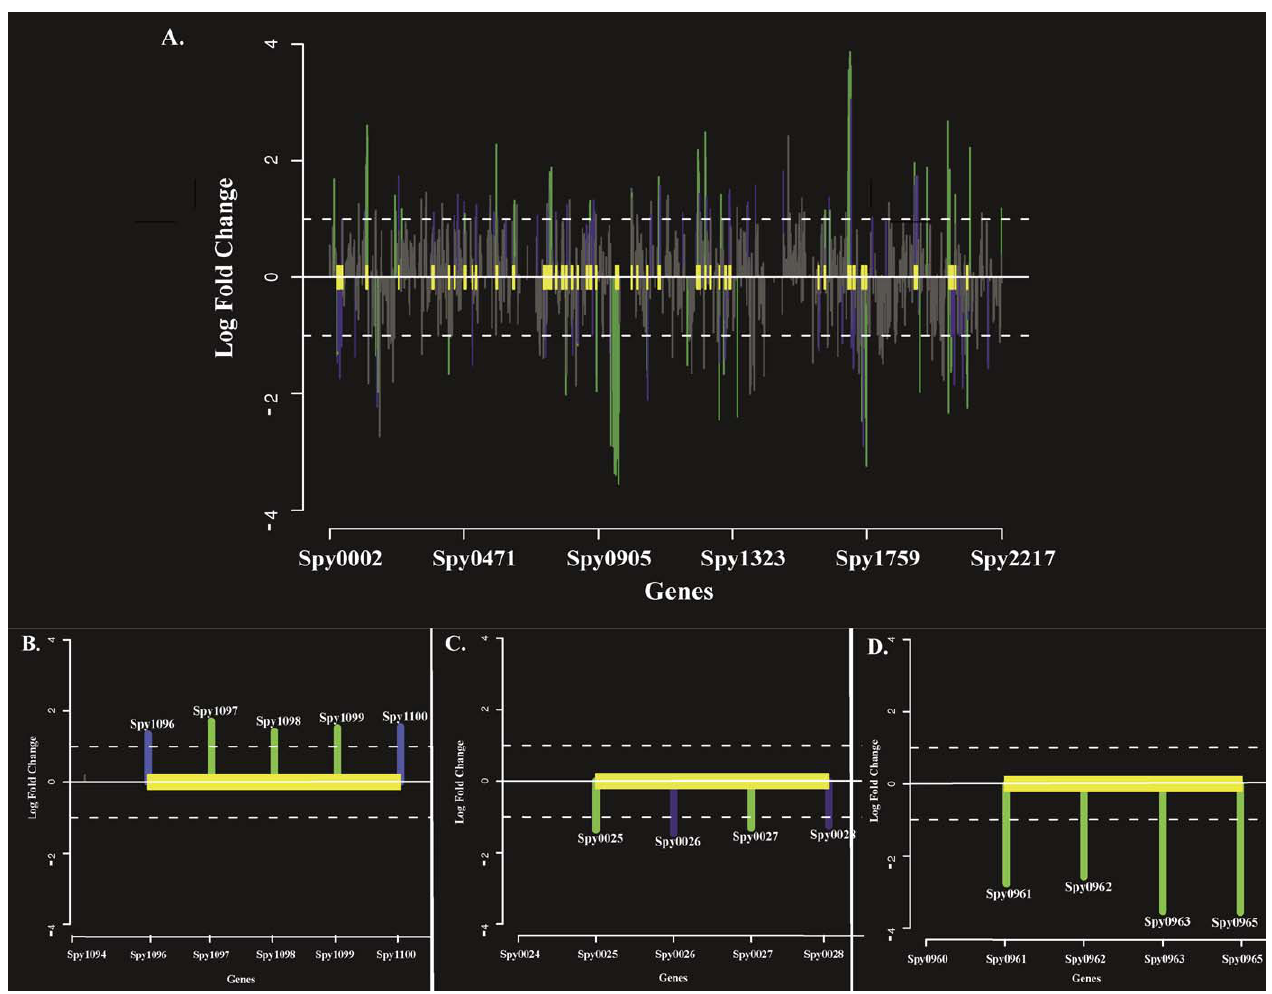
Figure 2. Statistically Significant Neighbor Clusters in the SF370 Genome Neighbor clusters that adhere to the definition of neighbor clusters are plotted by GenomeSpyer. Yellow boxes denote boundaries of significant neighbor clusters ( P K value , 0.05). Genes, located on the x -axis, are identified by their Spy numbers from the annotated SF370 genome (deleted gene numbers result during genome updates); log 2 -fold change in expression values (adherence versus associated streptococci) are indicated on the y -axis. Genes designated by green lines have statistically significant P F values (log 2 -fold change P values , 0.05) and P E values (expression P values , 0.05). Genes designated by blue lines do not have statistically significant P F values, but as a result of membership in a designated neighbor cluster have statistically significant P E values ( P E values , 0.05). Genes designated by gray lines do not have statistically significant P F or P E values. (A) Whole-genome view of 47 statistically significant neighbor clusters identified in the SF370 genome during adherence to pharyngeal cells. (B) Enlarged view of representative Type I cluster encoding folate biosynthesis genes (spy1096–1100). Type I clusters contain only genes of known or defined function. See text for further descriptions of all clusters. Spy numbers are indicated above the bars corresponding to each gene. (C) Enlarged view of representative Type II cluster containing spy0127–0130. Type II clusters contain a combination of both functionally defined and unknown gene members. (D) Enlarged view of representative Type III cluster containing phage encoded genes of unknown function (spy0961–0965). Type III clusters contain only genes of unknown or undefined